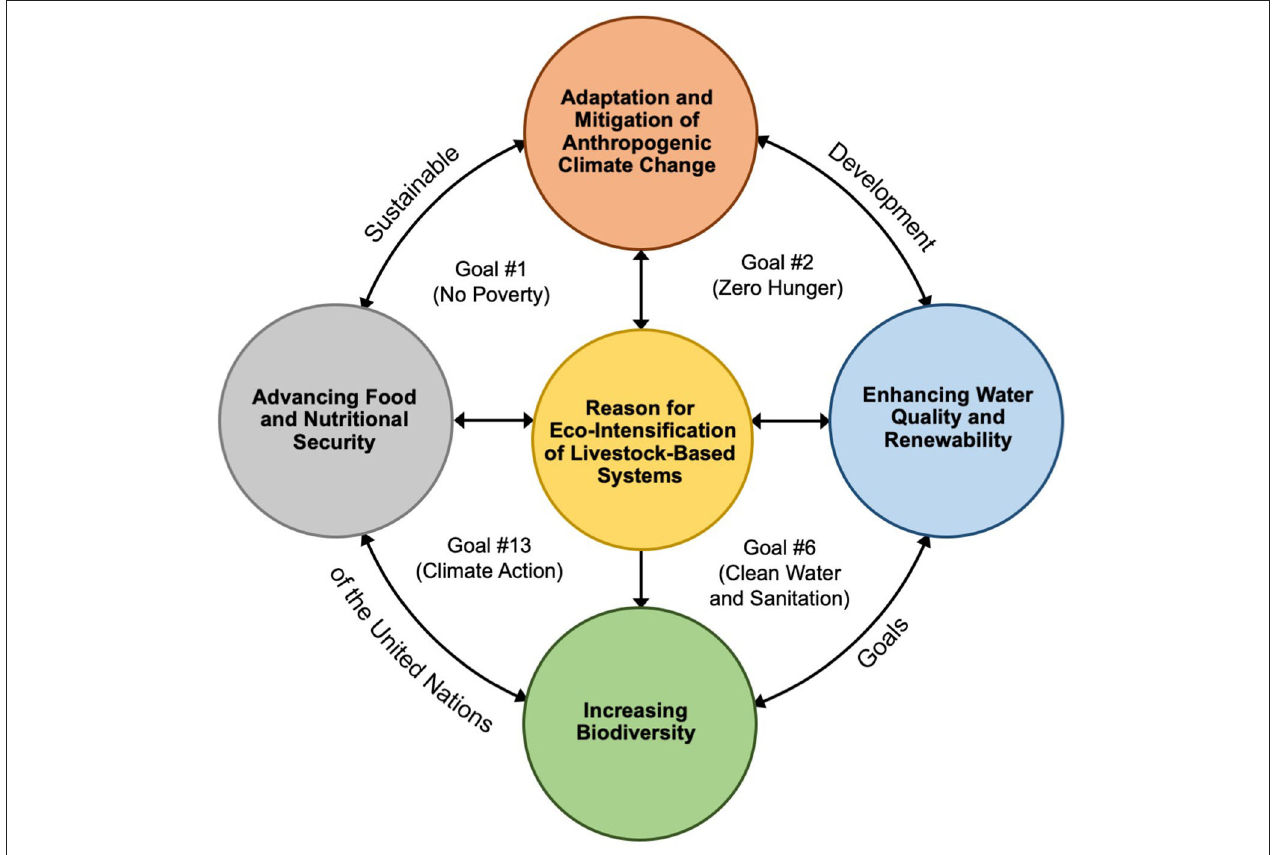
FIGURE 1 | Eco-intensification of livestock-based systems to advance the Sustainable Development Goals of the United